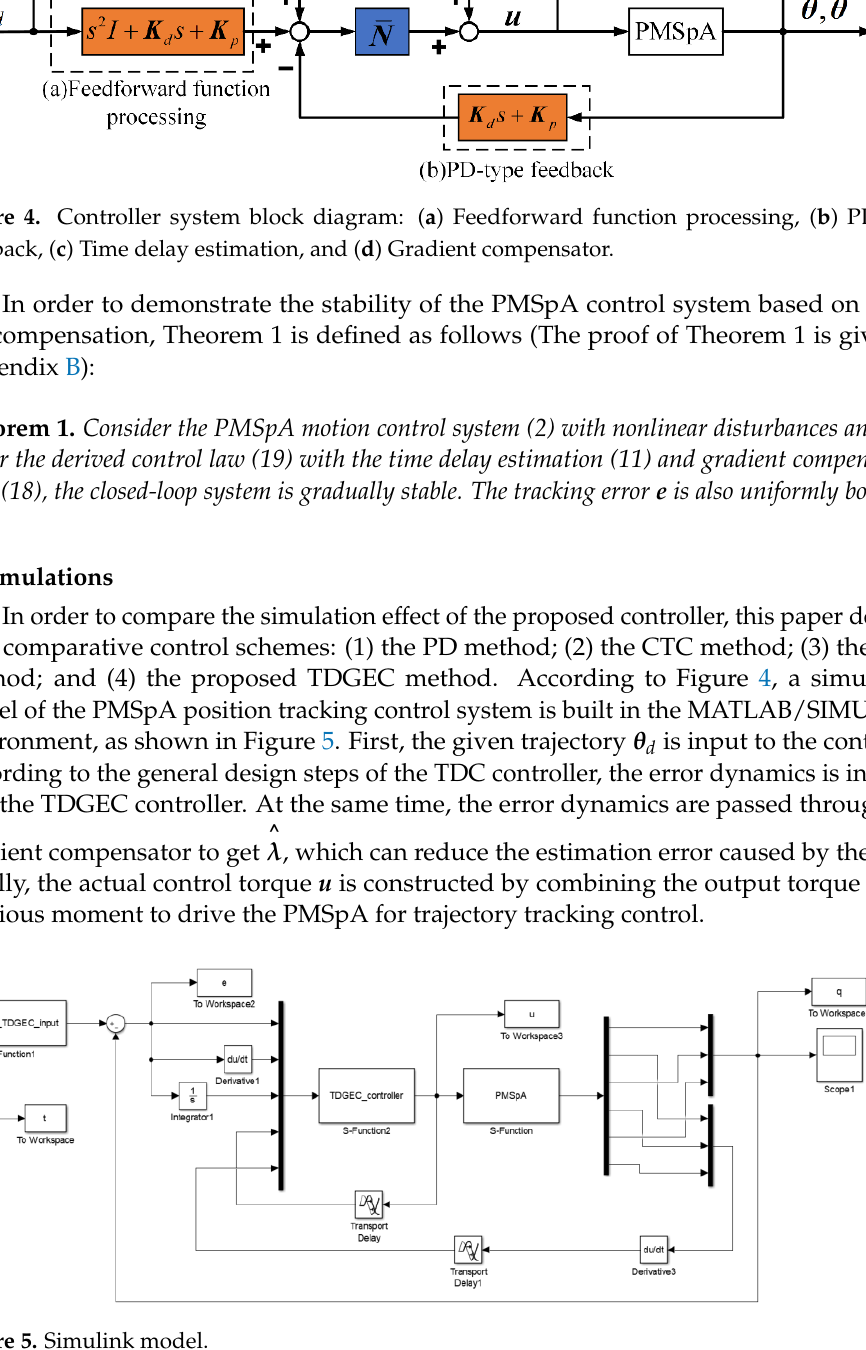
Figure 5. Simulink model. Figure 5. Simulink